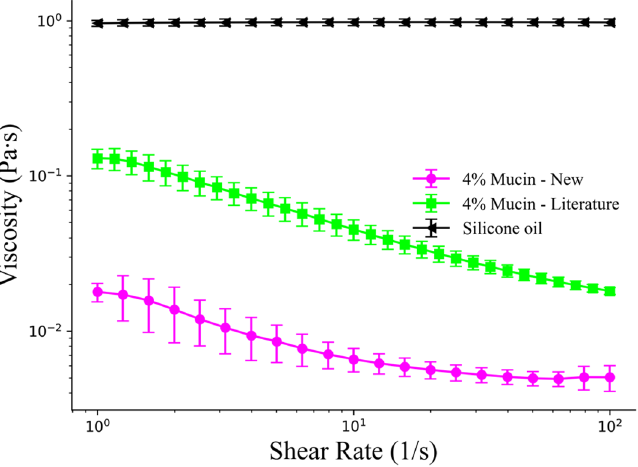
Figure 2. Viscosity vs. shear rate curves for different fluids. The data points in ‘4% Mucin–Literature’ were obtained from literature, while ‘4% Mucin–New’ contains data obtained from recharacterization. Silicone oil was used to demonstrate behavior of a Newtonian fluid and verify rheometer calibration. Error bars represent standard error over a minimum of three trials. Lines between points are a visual aide and do not represent